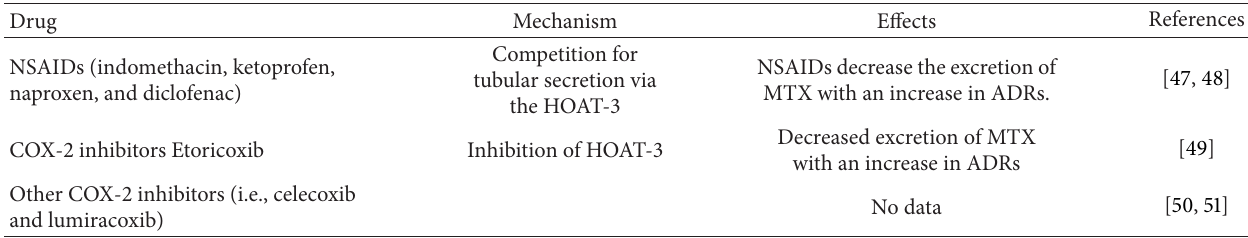
Table 3: DDIs between MTX and NSAIDs.